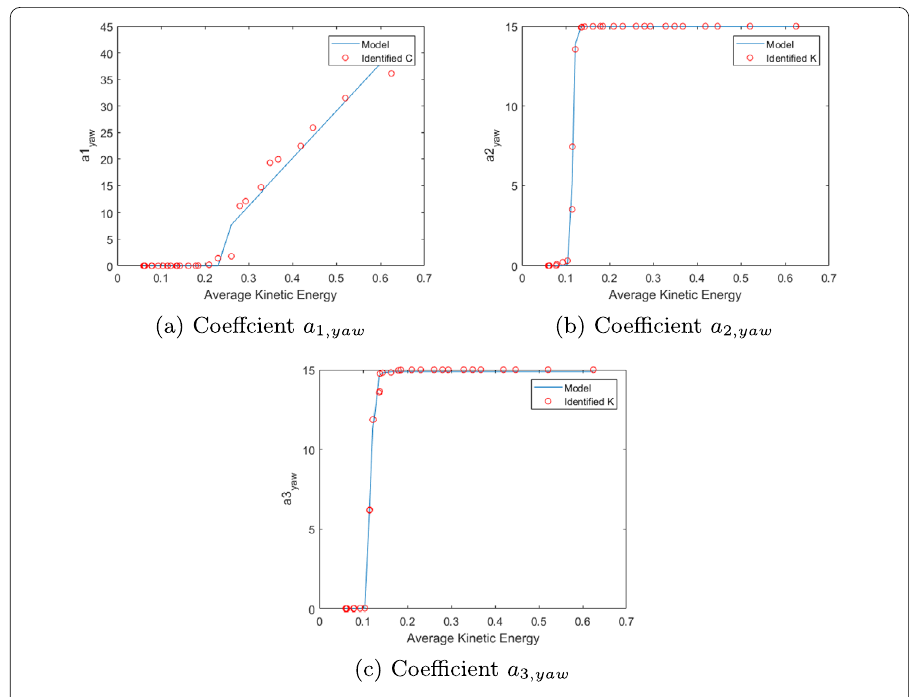
Figure 23 Comparison between the coefficients against their models for the yaw axis